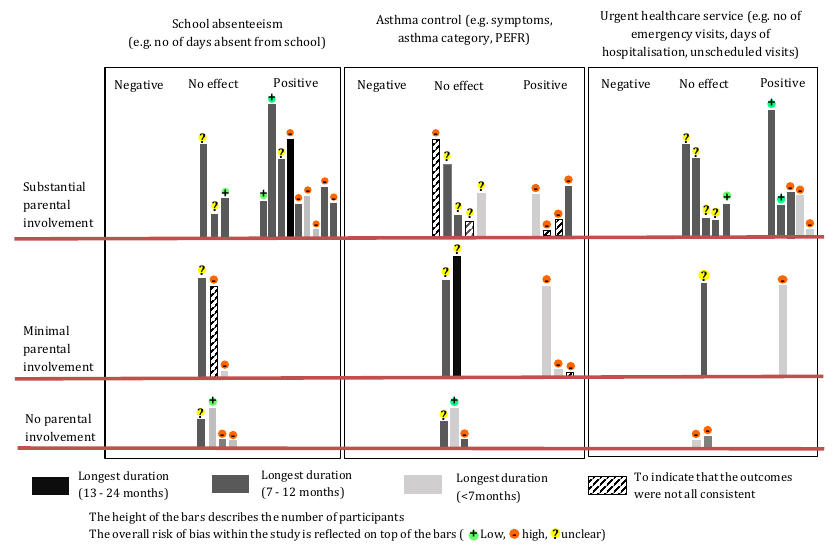
Fig. 2 Harvest plot illustrating effectiveness of included studies across parental involvement. Harvest plot illustrating the effectiveness on school absenteeism, asthma control and urgent healthcare services across parental involvement for school-based self-management asthma educational intervention. The shading of the bars indicates the duration of the study and the height of the bars describes the number of participants. The overall risk of bias is re fl ected on top of the